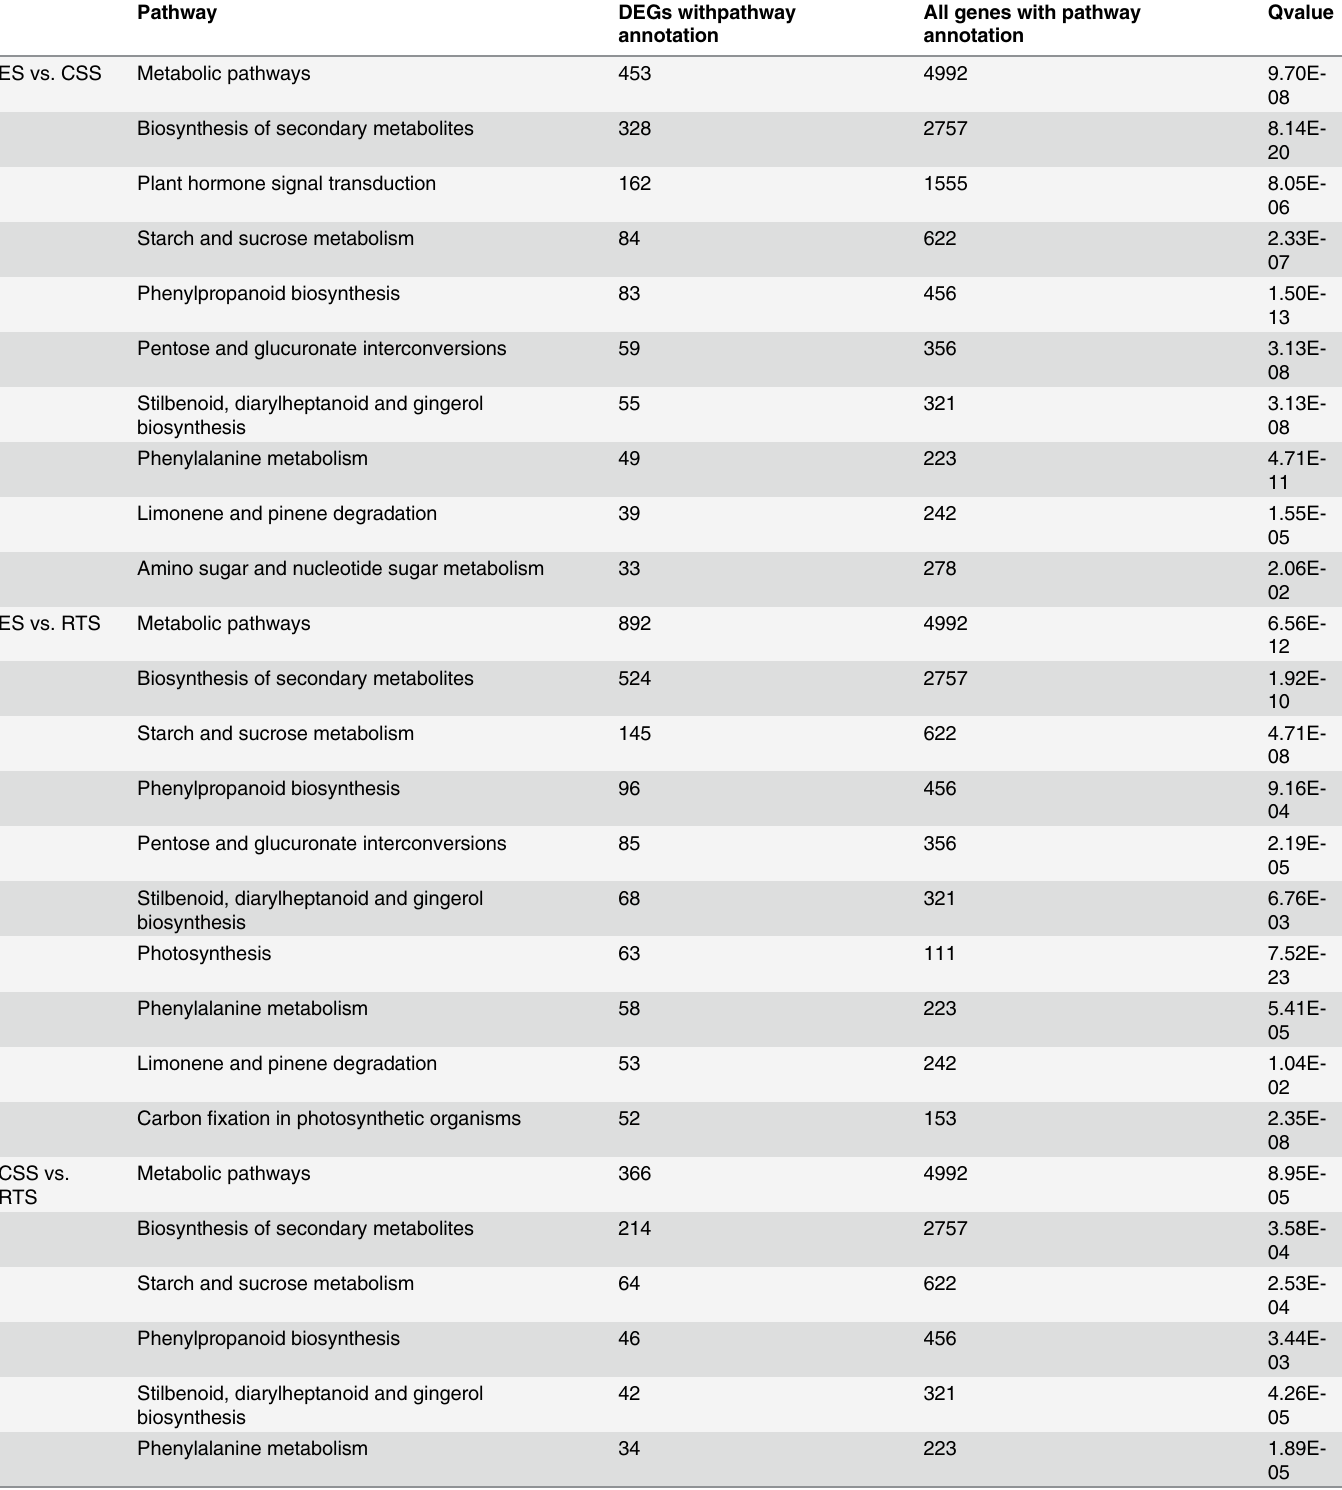
Table 2. Pathway enrichment analysis of differentially expressed genes (Top ten enriched pathways are